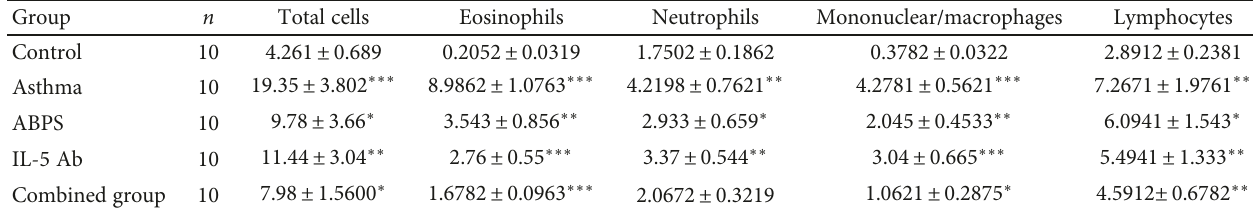
Table 1: The total and sorting cell count of each group in BALF ( ∗ 10 4 /mL, x ± s).